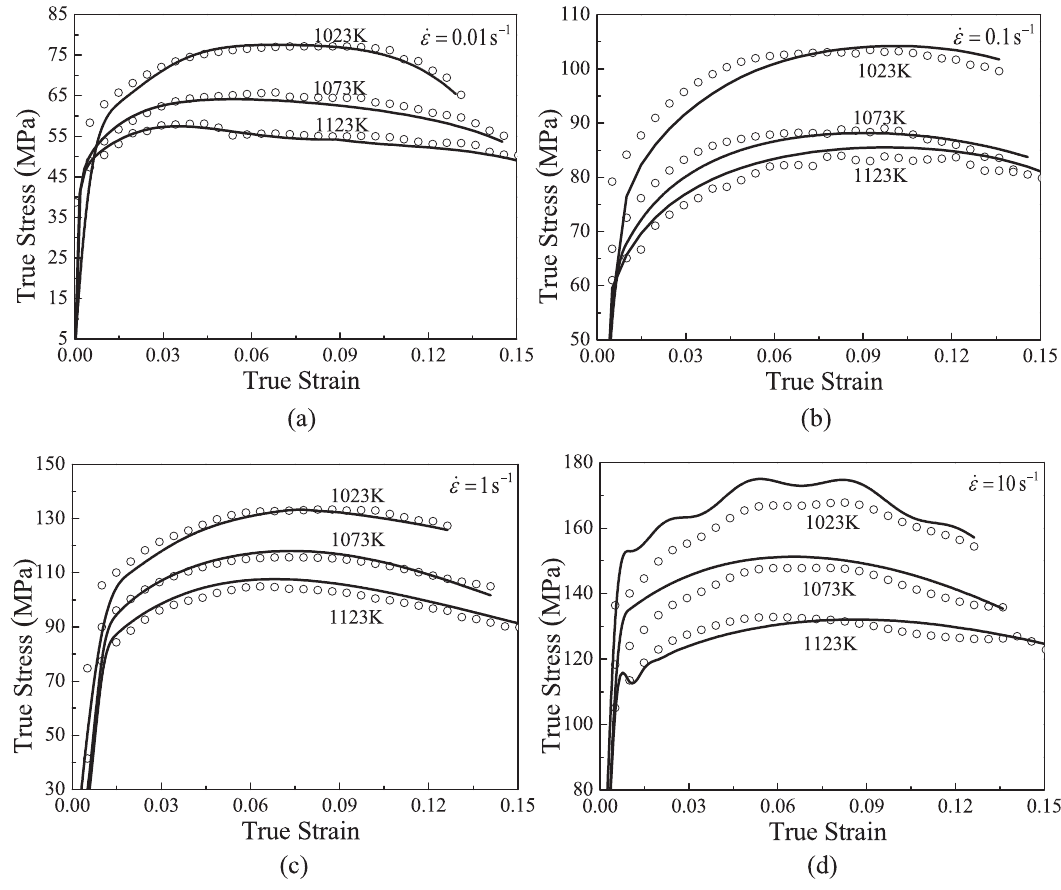
Fig. 8: Comparisons between predicted (circles) and measured (solid lines) of BR1500HS alloy under different deformation temperatures with strain rates of (a) 0.01 s − 1 ; (b) 0.1 s − 1 ; (c) 1 s − 1 and (d) 10 s − 1